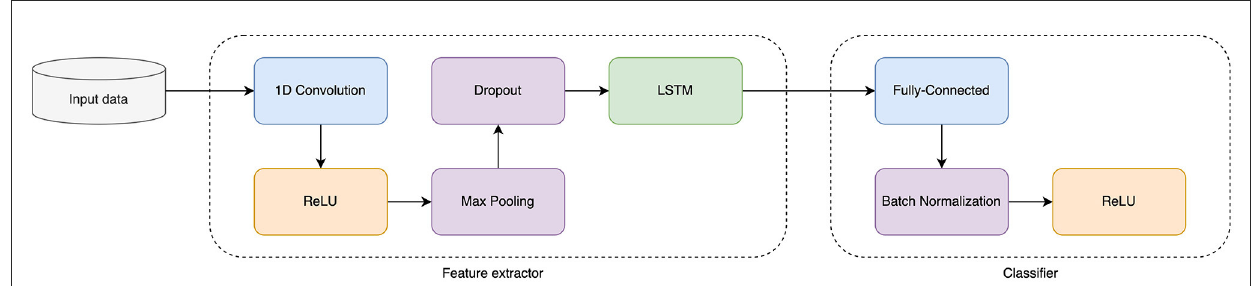
FIGURE1 General schema for domain adaptation models. In contrast to the standard deep learning methods, DA approaches use two separate sets of training data: source domain data both with genomic regions and corresponding labels, and target domain unlabeled region dataset. The second dataset allows the transfer learning mechanism to work, as after the model training stage the learned features in the feature extractor would contain information that is specific for both source and target